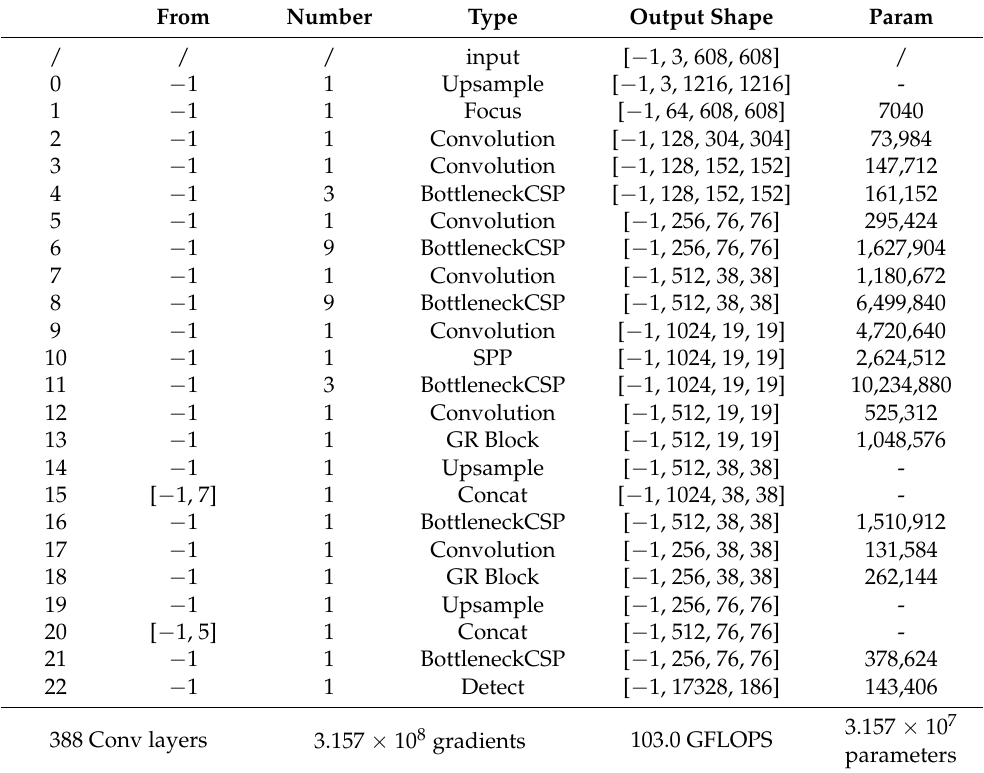
Table 1. SSRD-Net Network